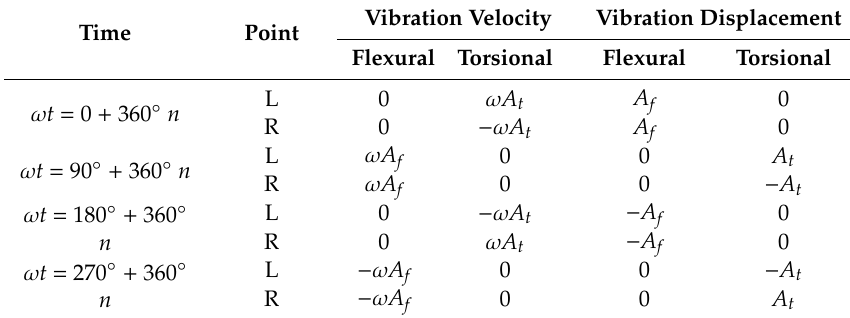
Figure 3. Working principle of the T / F motor. Deformations for the vibration modes are given and the arrows in each circle indicates the direction of each elliptical motion. Table 1. Vibration velocities and vibration displacements at di ff erent time. Vibration Velocity Vibration Displacement Time Point Flexural Torsional